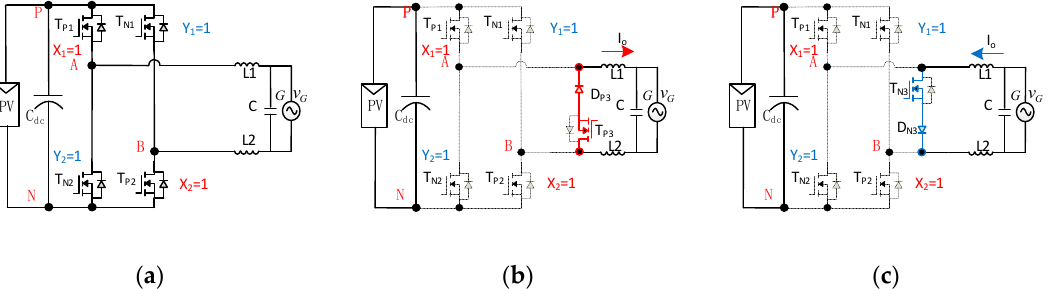
Figure 8. Four modes under X 1 = 1, X 2 = 1, Y 1 = 1, and Y 2 = 1. ( a ) PC and NC modes; ( b ) PF mode; ( c ) NF mode.